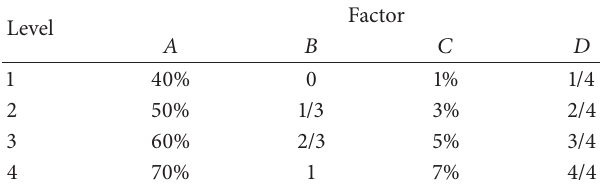
Table 1: Levels of each factor.